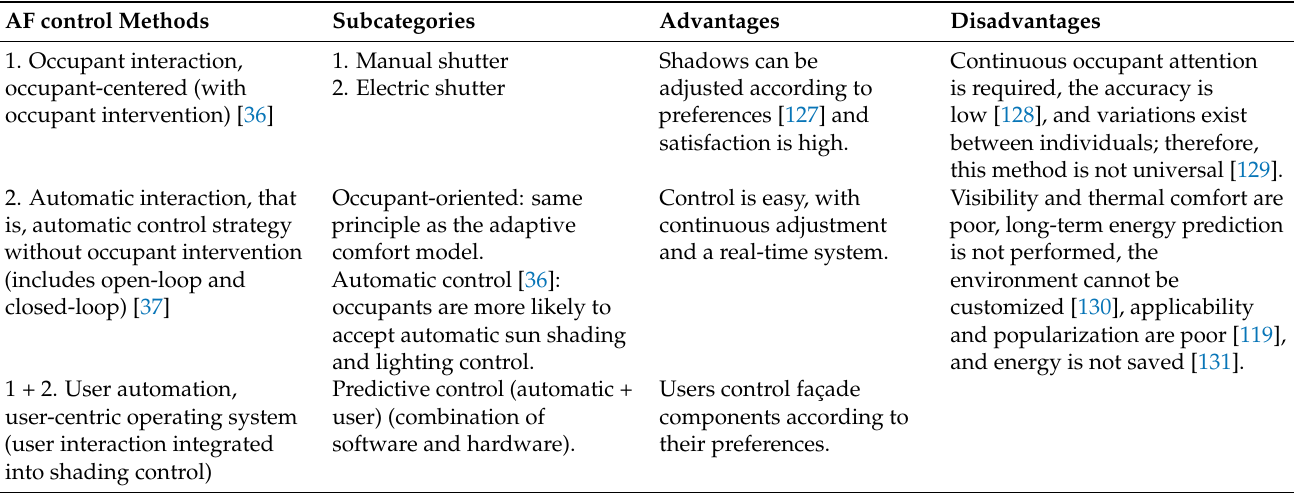
Table 5. AF control